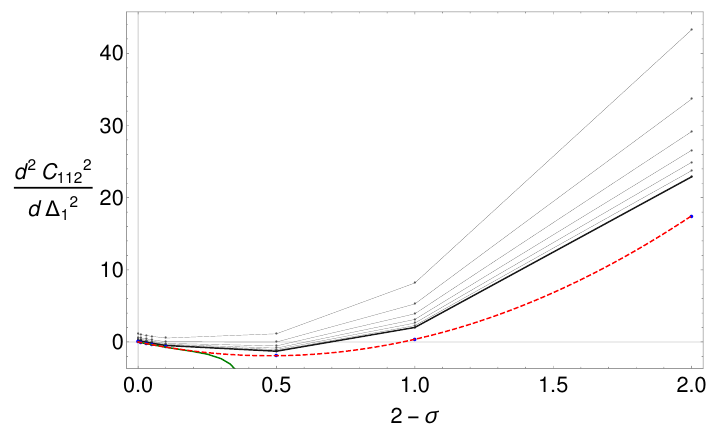
Figure 2 . The second derivative of c 112 with respect to ∆ 1 , at the free theory point, as a function of σ = (∆ 2 − 2) / (∆ 1 − 1) . The dashed red φ 4 curve coincides to high precision with the extrapolation of the numerical results to infinite Λ which are represented by the blue points. On the other hand, the sine-Gordon curve (in green) is